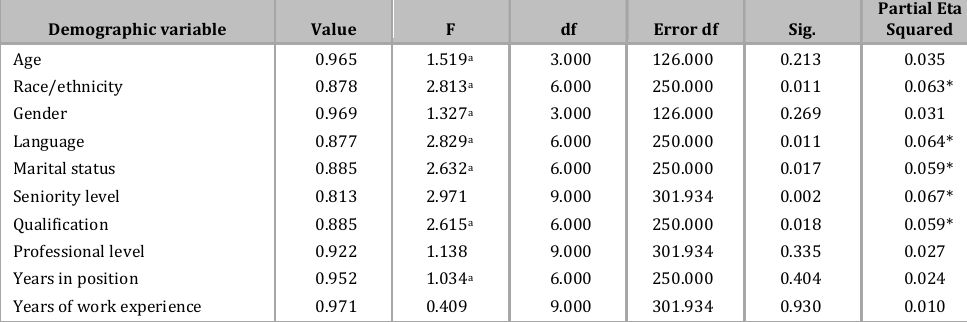
MANOVAs: Wilk’s lambda demographic variables and the PSA-PsyCap